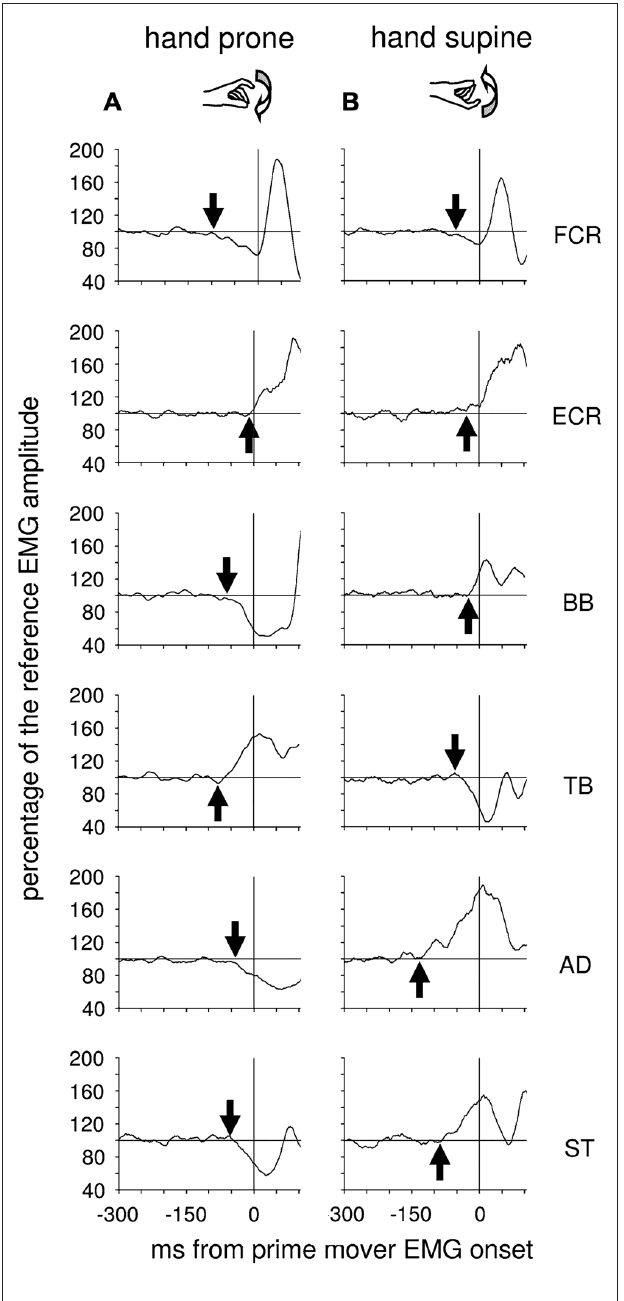
FIGURE 1 | Postural adjustments in upper-limb muscles preceding an index-finger tap with the prone or supine hand. Each graph displays the Anticipatory Postural Adjustments (APA) onset (arrow) and its development on the tonic EMG from different postural muscles of a single representative subject, with the hand resting prone (A) or supine (B) . Postural muscles: flexor carpi radialis (FCR), extensor carpi radialis (ECR), biceps brachii (BB), triceps brachii (TB), anterior deltoid (AD), superior trapezius (ST). The vertical line at 0 ms marks the onset of the prime mover activity. Note that in the muscles acting at the elbow, the shoulder and the trunk APAs reverts in sign when hand posture changes from prone to supine. EMG is rectified, integrated and averaged (75 trials) and its size expressed in percentage of the mean EMG level recorded 1 s before the go signal. Reproduced from Caronni and Cavallari (2009a), © Springer-Verlag 2008, with permission of Springer